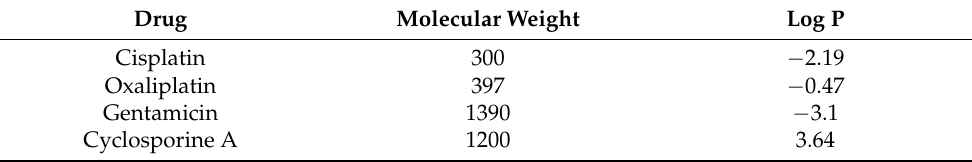
Table 2. Molecular weight and partition coefficient of nephrotoxic drugs